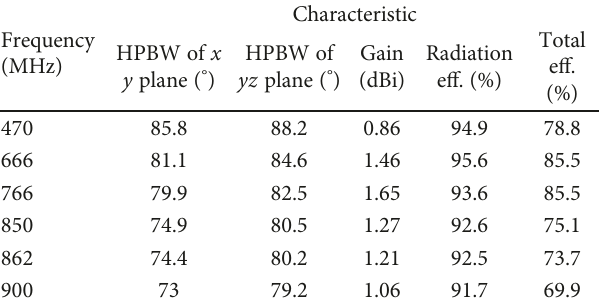
Figure 14: The simulated radiation and total e ffi ciencies and simulated and measured gains of the MD-loaded MLA. Table 2: The radiation performance of the proposed MD-loaded